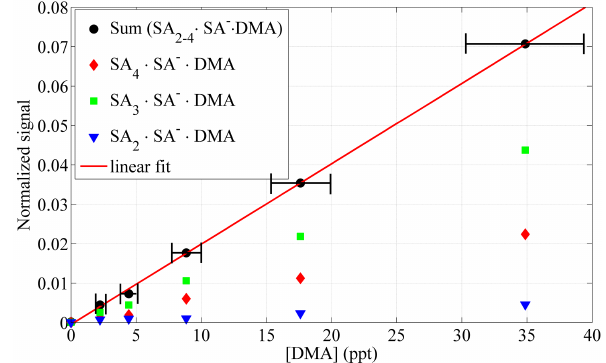
Figure 5. Mass spectra with [DMA] = 2.22pptV, the lowest stud- ied [DMA]; and the background signal (in the absence of added DMA) without and after the baking and flushing of the CLOUD chamber. Integration time is 15min. The principal peak is located at 435.92Th; the first of the isotopes 436.92Th is partly overlap- ping with signal from an unidentified compound. The second iso- tope at 437.92Th is, however, clearly visible. The signal at 437.6Th originates from a chlorine-containing substance, whose source is unknown. Lowest detection limit was defined as three times the background signal at main peak (435.92Th) and was found to be 70ppqV (0.07pptV). Practically, ultimate sensitivity is limited by contamination in blank air or on inlet surfaces. A high-resolution fit of DMA is also shown and represents the ideal distribution of signal in the absence of overlapping signals from other compounds.